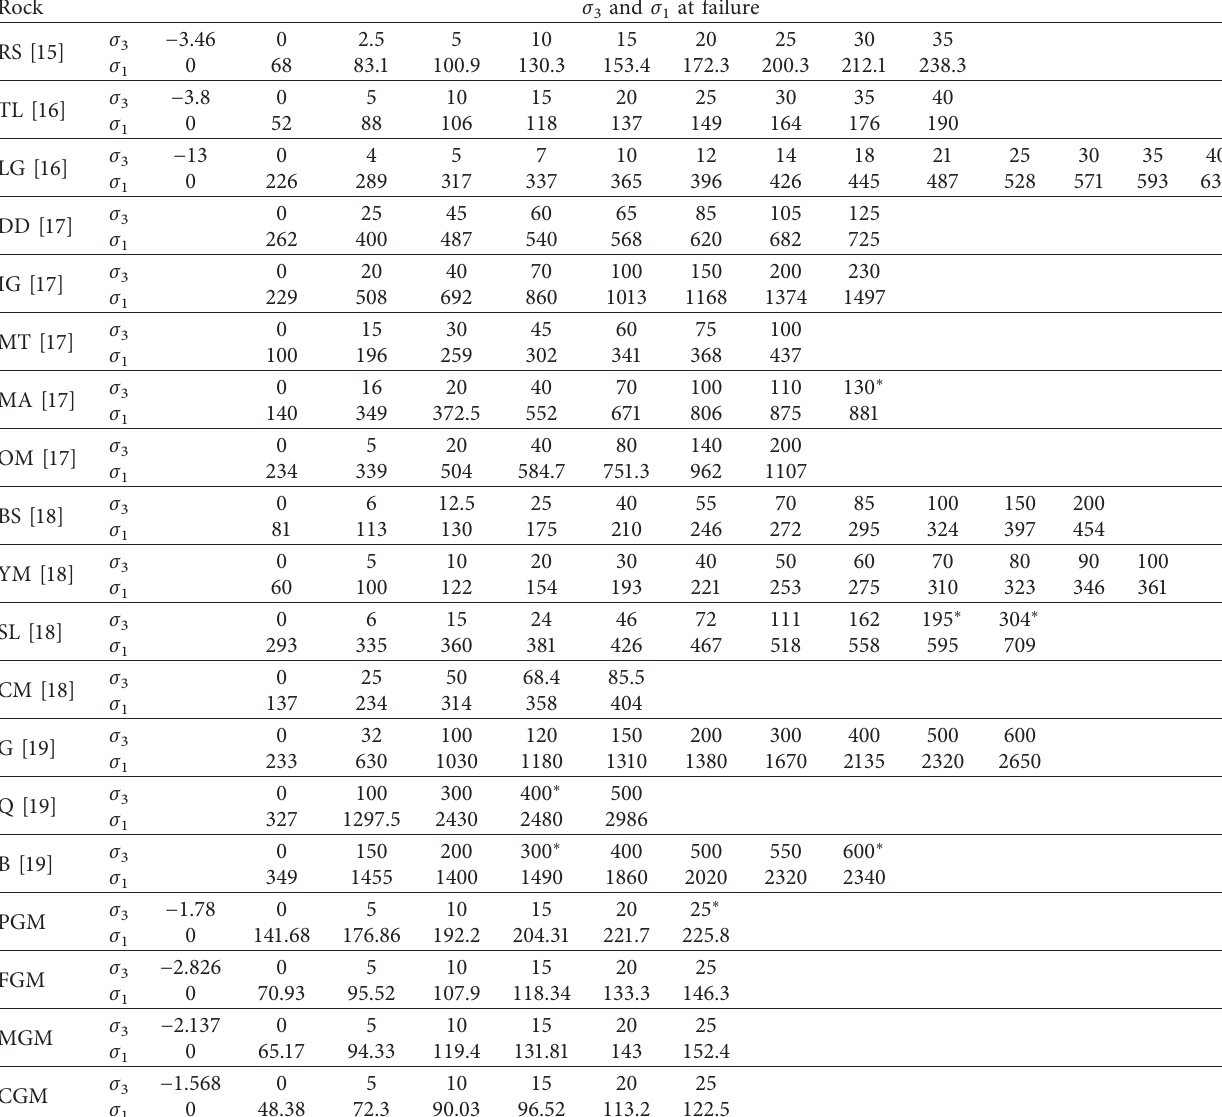
Table 1: Conventional triaxial compression strengths